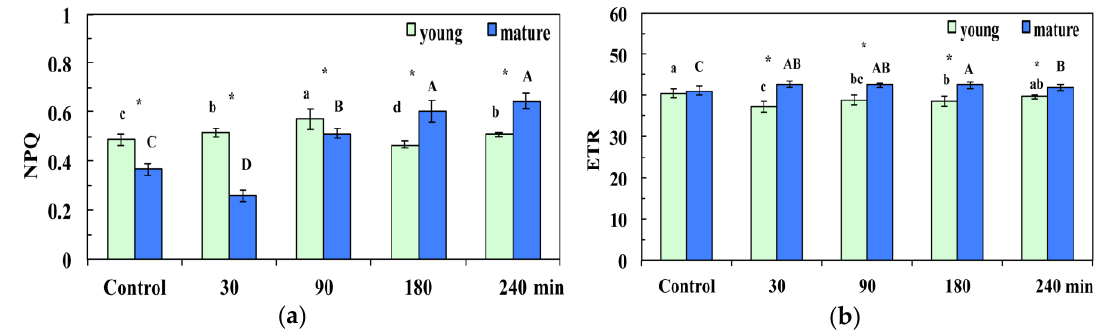
Figure 5. Changes in the non-photochemical fluorescence quenching (NPQ) ( a ), and the relative PSII electron transport rate (ETR) ( b ); of Arabidopsis thaliana young and mature leaves measured (at 140 μmol photons m −2 s −1 ) 30 min, 90 min, 180 min, and 240 min after the foliar spay with 30 mg L −1 of CuZn NPs or distilled water (control). Error bars on columns are standard deviations based on four to five leaves from different plants. Columns with different letter (lower case for young leaves and capitals for mature) are statistically different ( p < 0.05). An asterisk (*) represents a significantly different mean of the same time treatment between young and mature leaves ( p < 0.05).